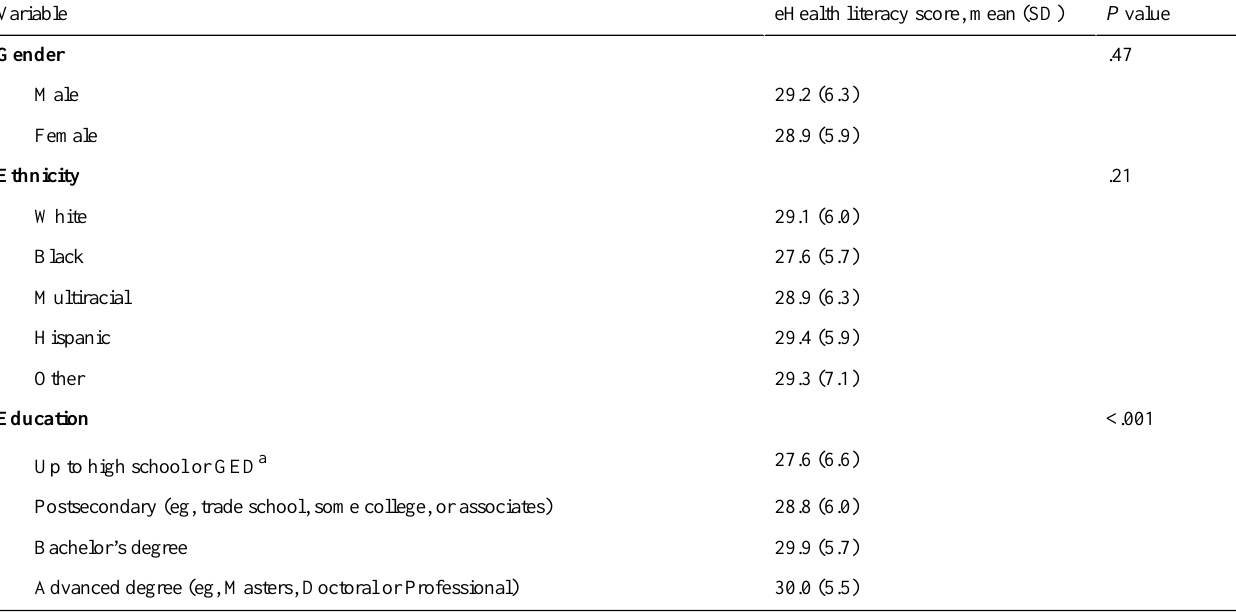
Table 2. Bivariate association between demographic characteristics and coronavirus-related eHealth literacy.